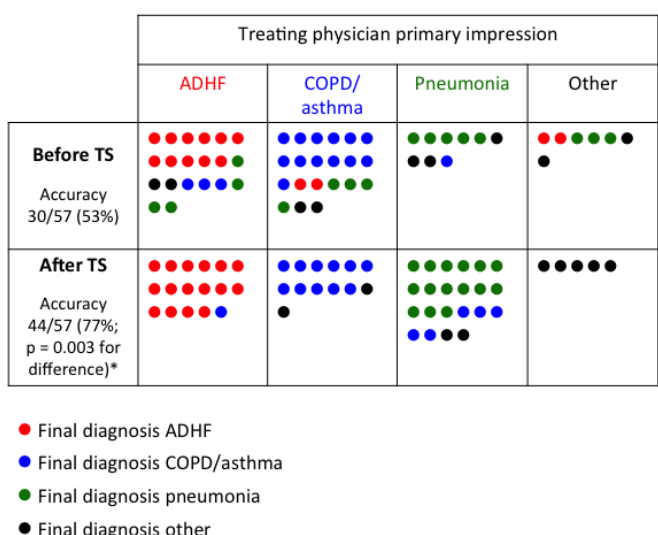
Figure 2. Case level data showing final diagnosis in each case. ADHF, acute decompensated heart failure; COPD, chronic obstructive pulmonary disease; TS, triple scan